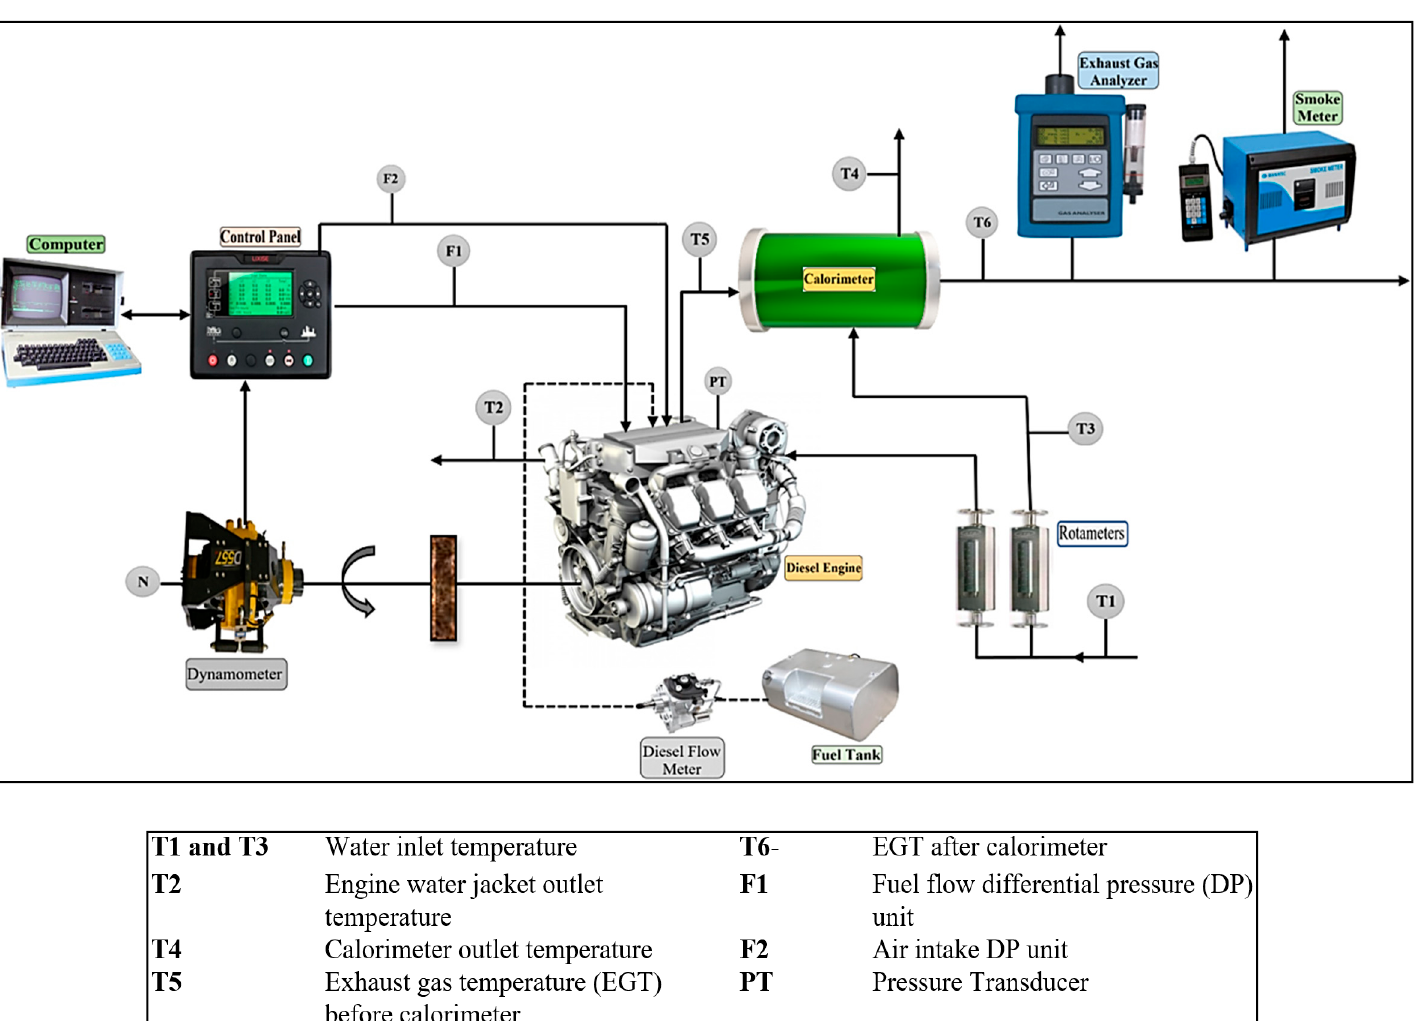
Figure 1. A layout of the test rig.